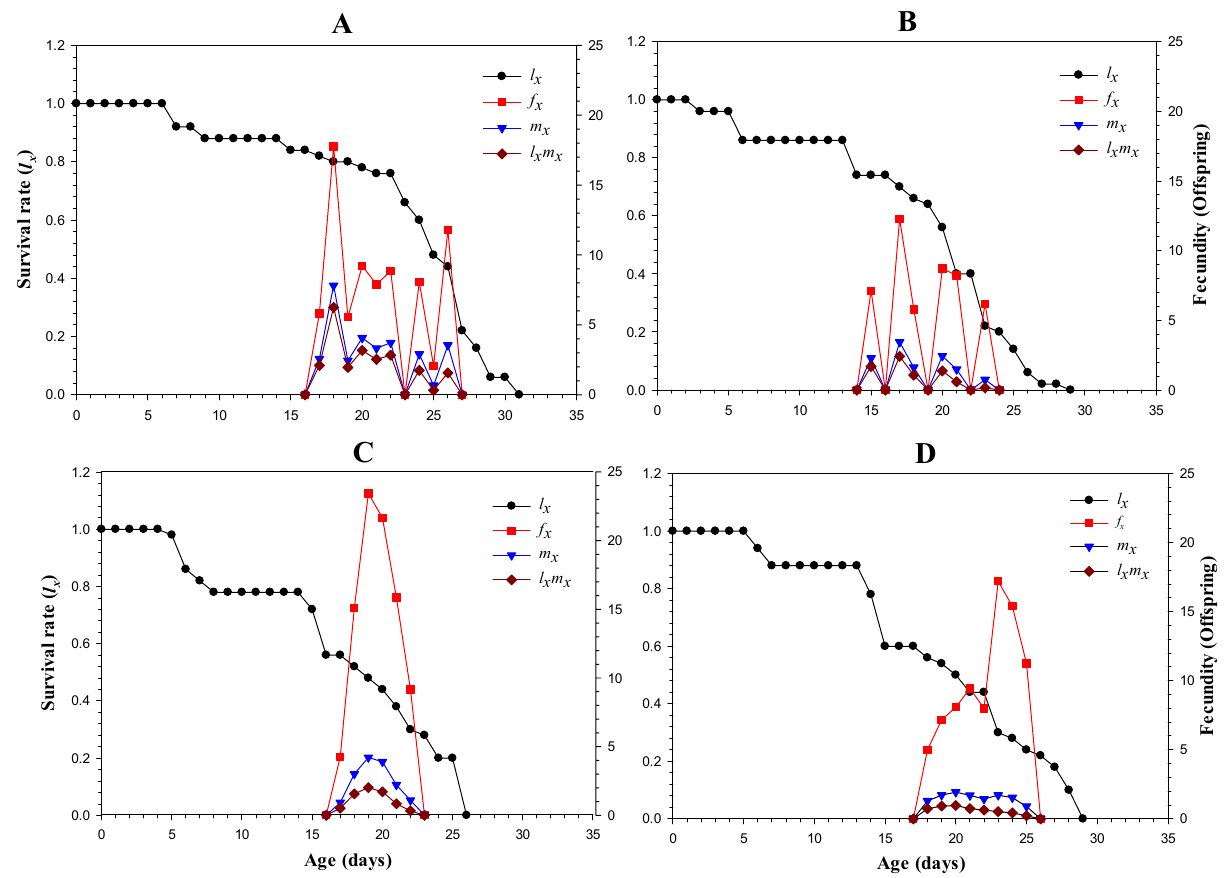
Figure 3. Transgenerational effect of Lambda-cyhalothrin, ( A ) control, ( B ) LC 10 , ( C ) LC 30 , and ( D ) LC 50 on Age-specific survival rate ( l x ), age-specific fecundity of total population ( m x ), and age-specific maternity ( l x m x ) of initial Musca domestica exposed to LC 10 , LC 30 and LC 50 of lambda-cyhalothrin in F 5 .